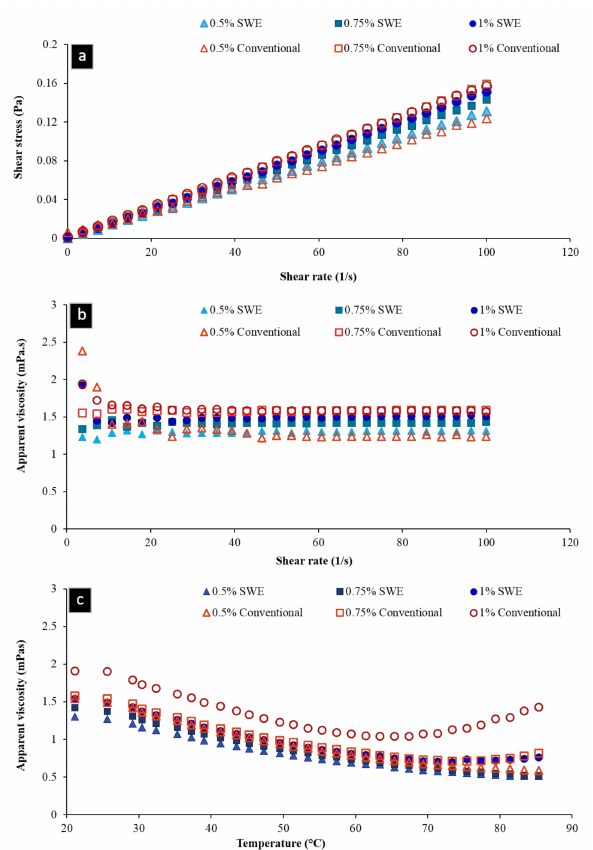
Figure 3. Shear stress of pectin solutions as a function of shear rate ( a ), shear-rate dependence of viscosity for various pectin solutions, ( b ) and temperature dependence of viscosity for various pectin solutions ( c